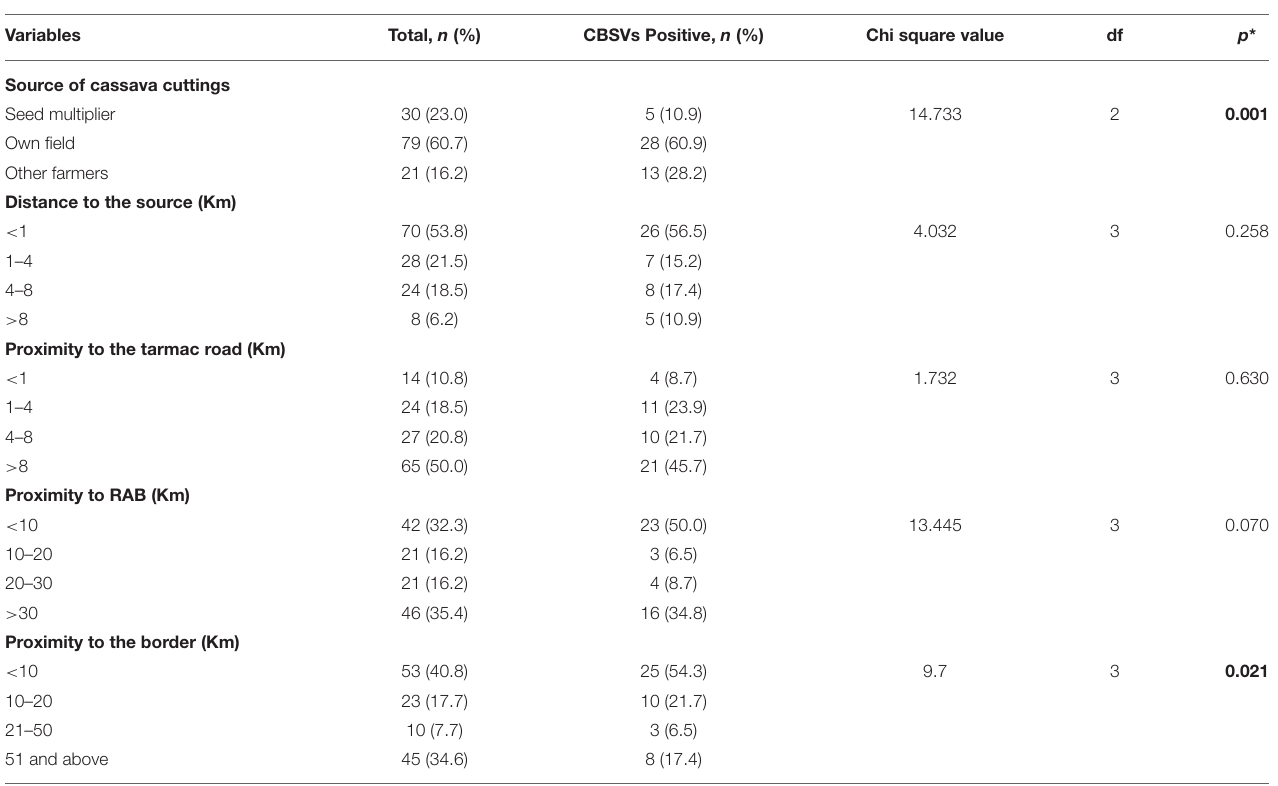
TABLE 2 | Impact of accessibility of planting materials on cassava